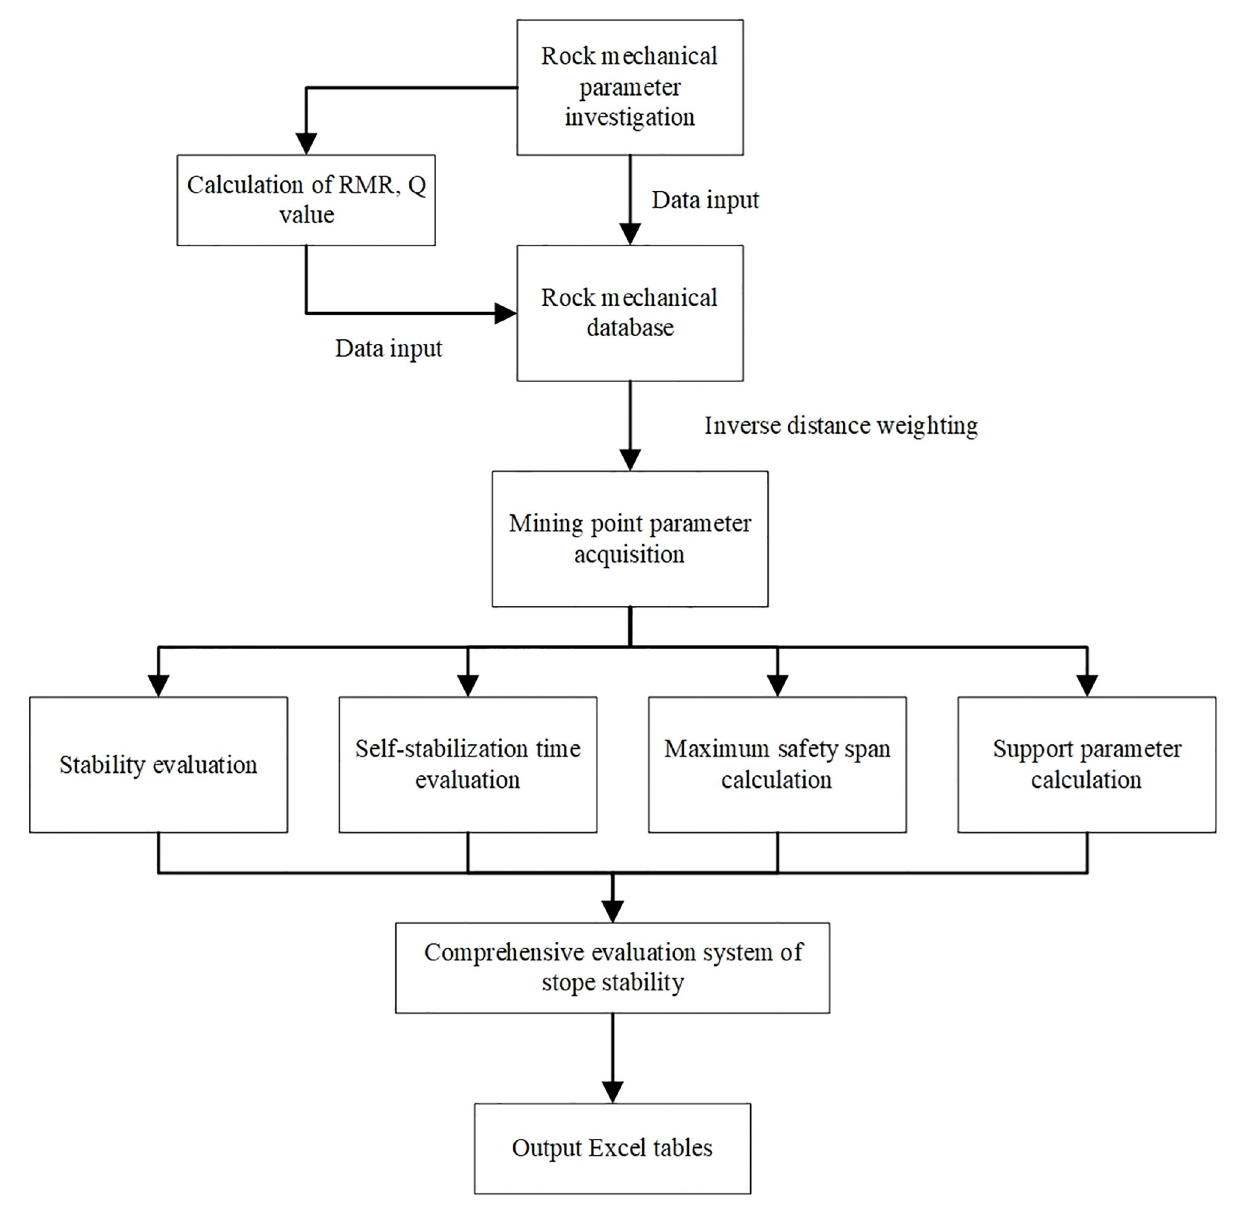
Fig 1. Flow chart of comprehensive evaluation